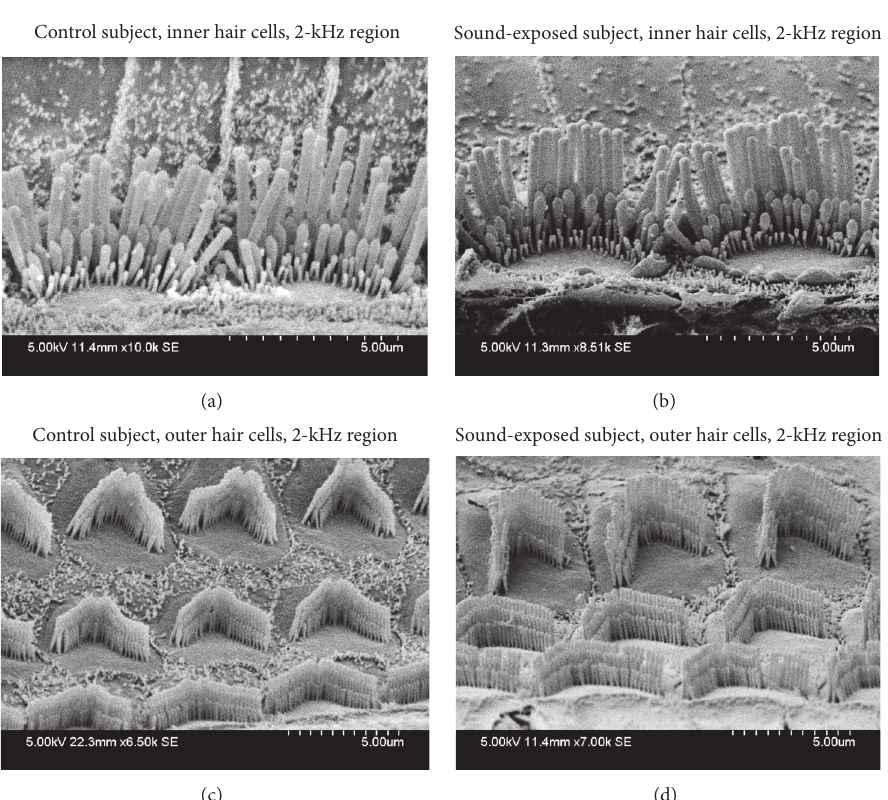
Figure 3: Representative samples of hair cells in the 2 kHz region of the cochlea in control ((a) and (c)) versus neonatally sound-exposed ((b) and (d))